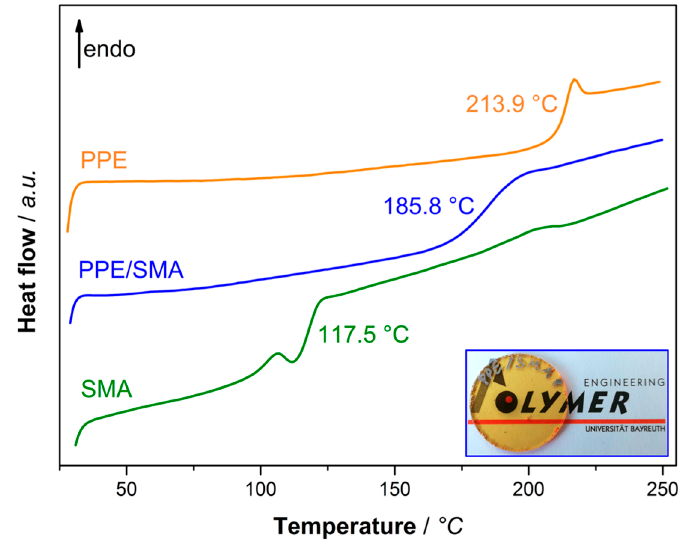
Figure 1. DSC thermograph of poly (2,6-dimethyl-1,4-phenylene ether) (PPE) (orange), Styrene-maleic anhydride copolymer (SMA) (green) and PPE / SMA blend (blue) at the blend ratio of 78 / 22. Hot-pressed disc of PPE / SMA blend for illustration of miscibility (right corner).